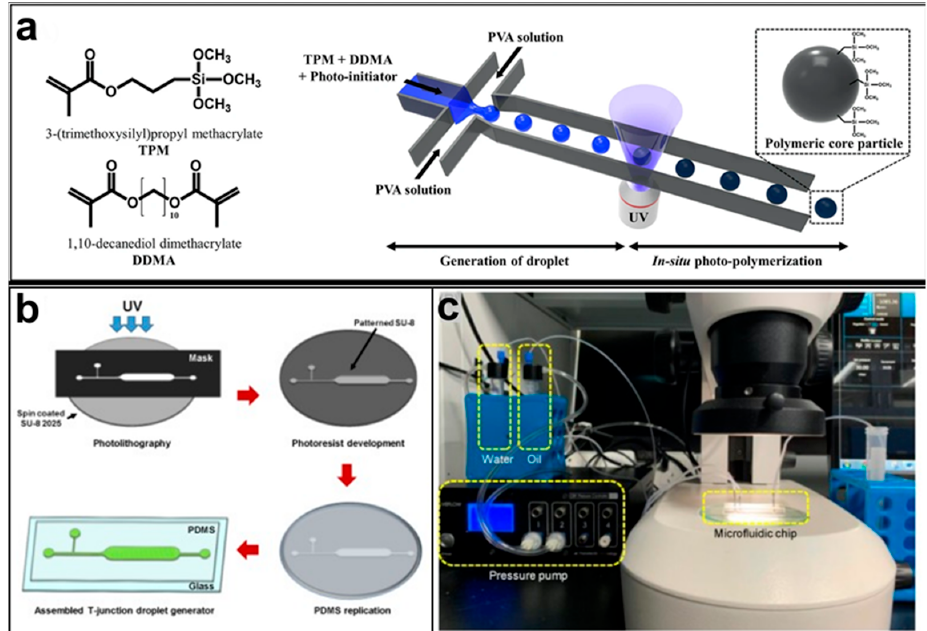
Figure 3. ( a ) Example of a flow-focusing chip to produce photocurable droplets containing the monomers (TPM and DDMA) and the photoinitiator in the continuous phase (PVA solution). Under UV-irradiation, photopolymerization is initiated. Reprinted from reference [97]. Copyright 2018, Scientific Reports. ( b ) The fabrication process of the T-junction chip to generate droplets by varying oil viscosity. ( c ) A photograph of the experimental setup. Reprinted from reference [100], Copyright 2019, Micromachines.